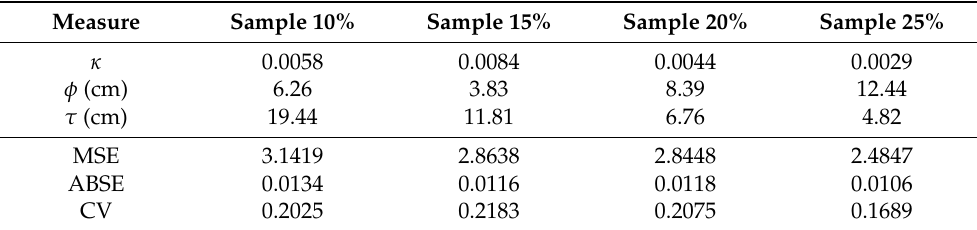
Table 2. Posterior distribution of the parameters and prediction errors for simple random sam- ples considered.